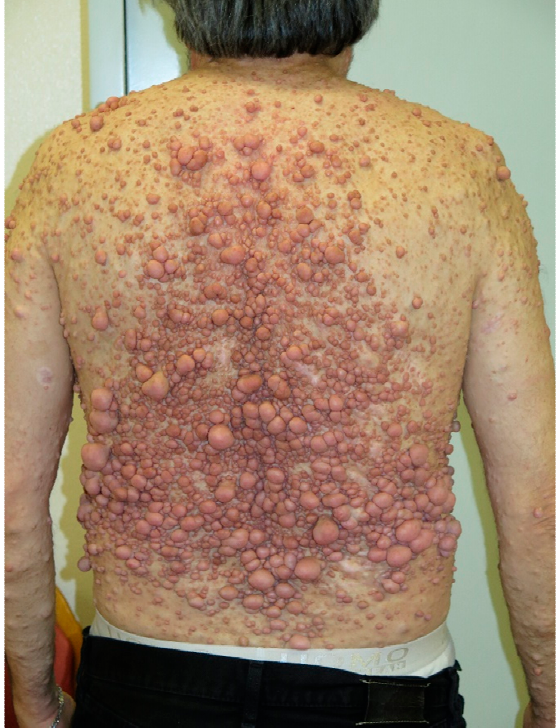
Figure 10. Diffuse neurofibromas on the back.